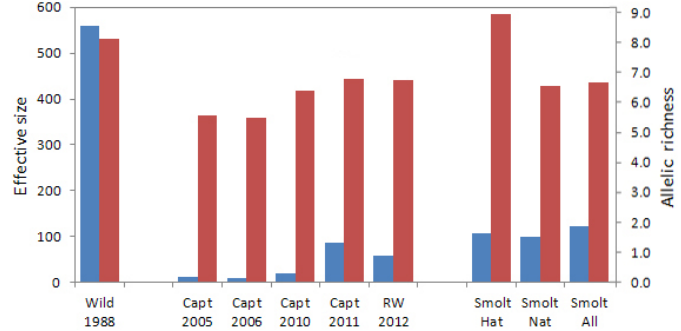
Figure 4. Allelic richness (red bars) for a standardized sample size of 70 fish and effective brood size (blue bars) for adult and smolt groups of wild, captive and reintroduced Sakinaw lake sockeye salmon.